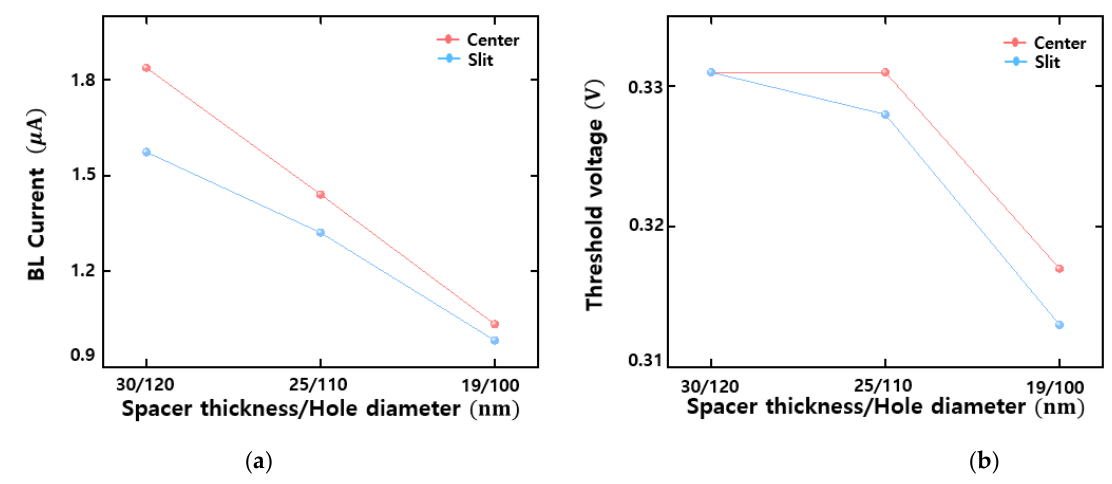
Figure 5. ( a ) BL current and ( b ) threshold voltage of two strings on WL5 when the spacer thickness and hole diameter are both scaled.